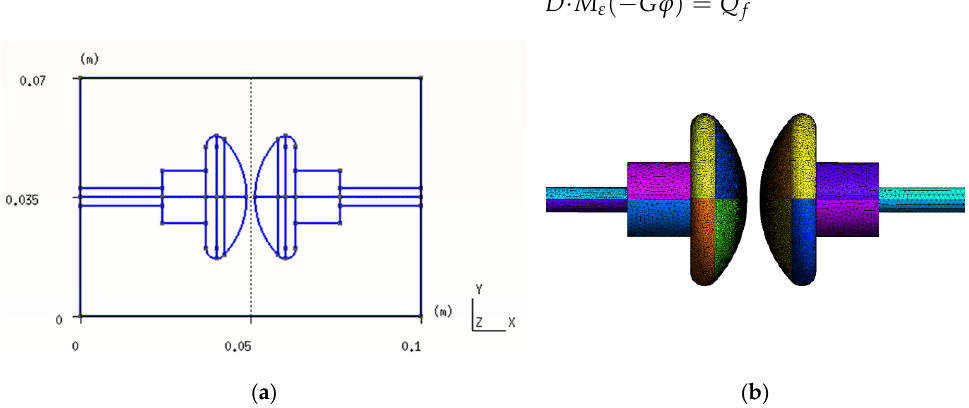
Figure 2. ( a ) Dimensions and coordinates of VDE-type electrodes. ( b ) Surface mesh, with 65,846 triangles, for the electrodes used in the tests.